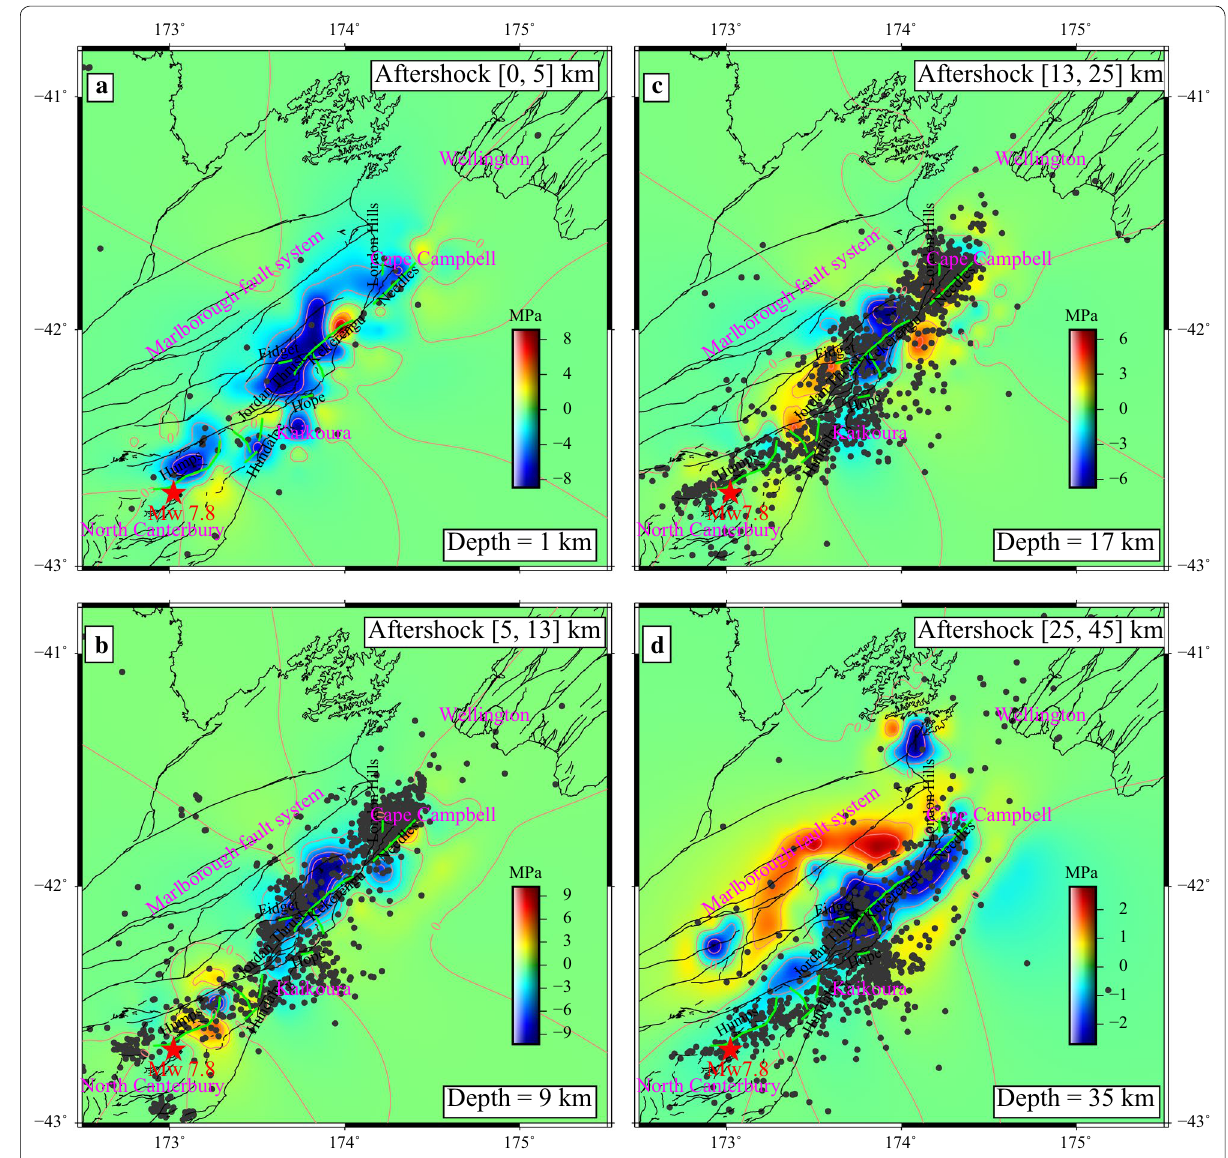
Fig. 7 Coseismic Coulomb stress changes in the mainshock regions. a – c Coseismic Coulomb stress changes corresponding to 1, 9, and 17 km depth, which reflect Coulomb stress changes on shallow receiver faults. d Coseismic Coulomb stress changes at 35 km depth at the southwestern Hikurangi subduction interface. The dark gray dots are the aftershocks based on the GeoNet earthquake